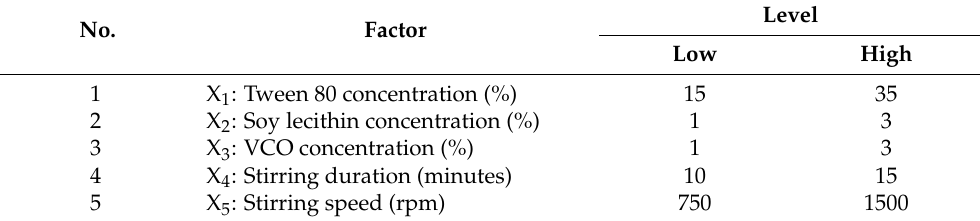
Table 1. Factors and levels for the 2 5 factorial design